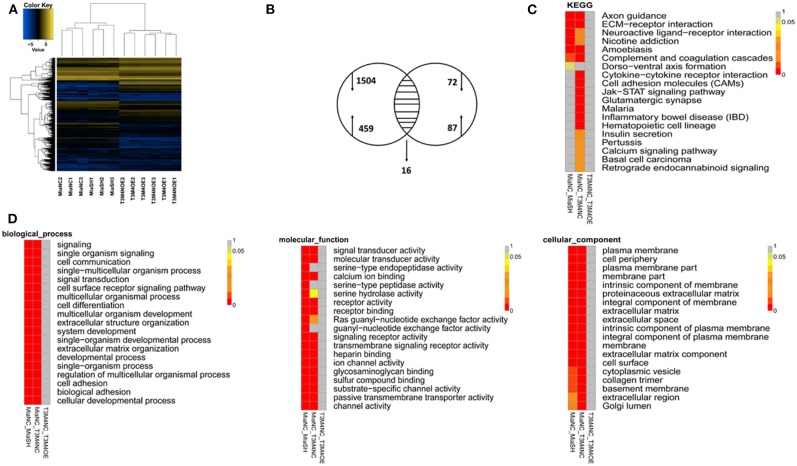
Bioinformatic screening for potential targeted molecules of TLE1. (A) Gene transcription profiles of genes that were positively or negatively regulated by TLE1 in MIA PaCa-2 and T3M4 cells. (B) Aberrant expression of TLE1-targeted genes in MIA PaCa-2 and T3M4 cells included in a Venn diagram. (C) The Kyoto Encyclopedia of Genes and Genomes (KEGG) pathway analyses for TLE1-regulated genes. (D) The representative Gene Ontology (GO) pathway analysis result for TLE1-regulated genes.